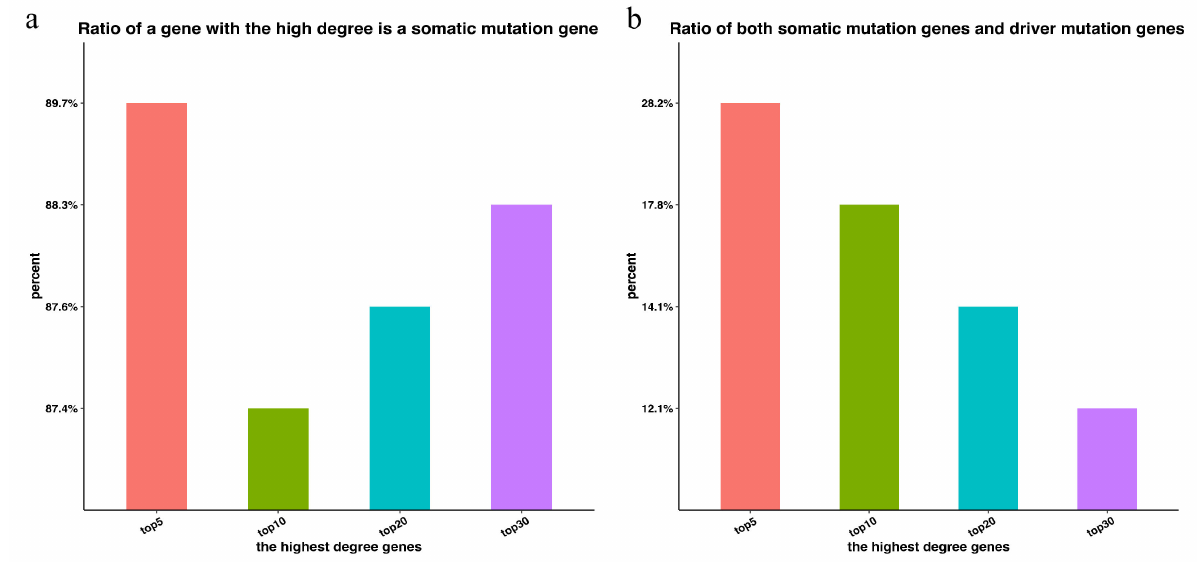
Figure 2. ( a ) The proportion of genes that are somatic mutation genes in the top 5, 10, 20 and 30 highest-degree genes in LUAD subpathways; ( b ) the proportion of genes that are both somatic mutation genes and driver mutation genes in the top 5, 10, 20 and 30 highest-degree genes in LUAD